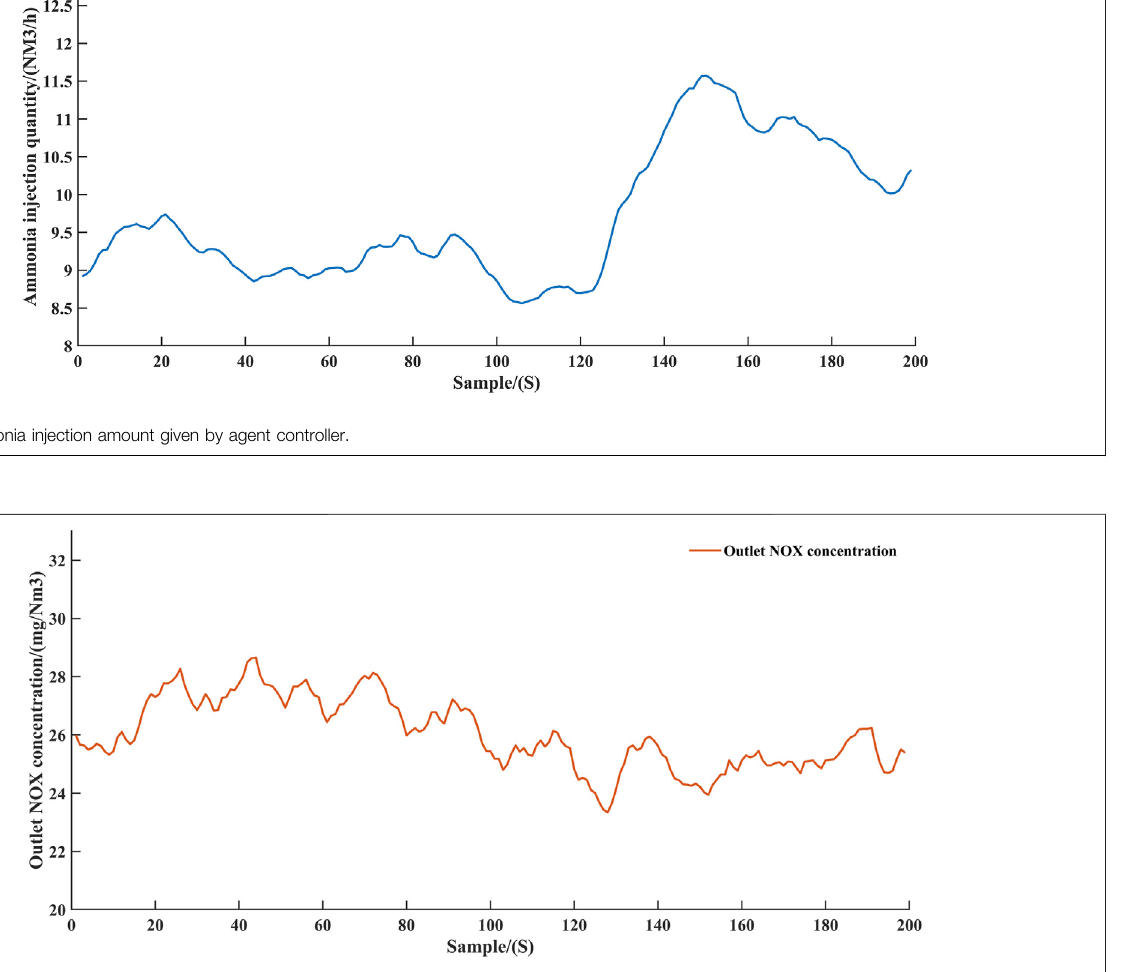
FIGURE 10 | NOx concentration at the outlet of reactor controlled by agent